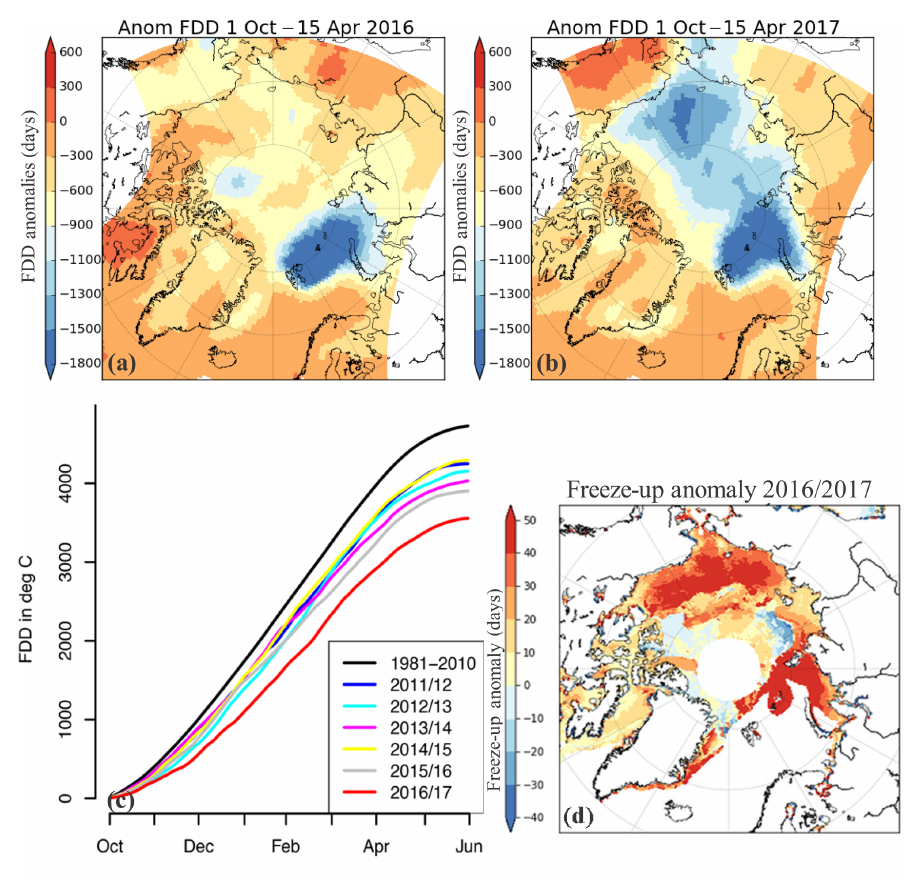
Figure 2. The top two panels show the freezing degree anomalies (FDD), computed as the number of days with NCEP2 2m air temperature below − 1.8 ◦ C from mid-November to mid-April in winter 2016 (a) , and winter 2017 (b) , computed relative to the 1981–2010 climatology. The bottom left image shows the cumulative freezing degree days (FDDs) averaged over region shown in Fig. 3 inset (c) , and the bottom right image shows freeze-up anomalies for 2016/2017 relative to 1981–2010 (d) . Areas in white are either missing (pole hole) or no sea ice in winter